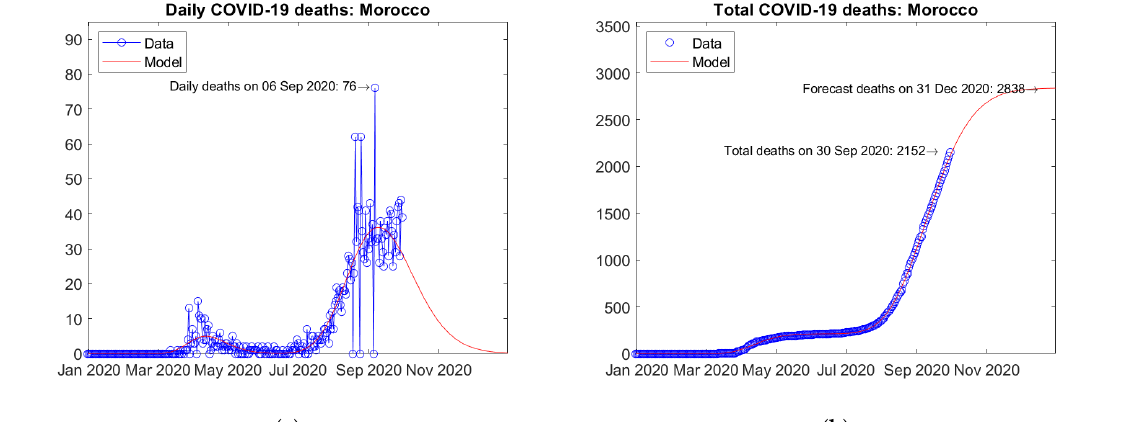
Figure 28. Actual and predicted trends in Morocco: ( a ) daily deaths, ( b ) total